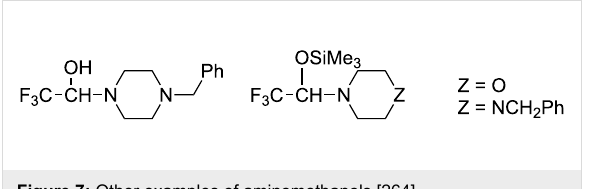
Figure 7: Other examples of aminomethanols